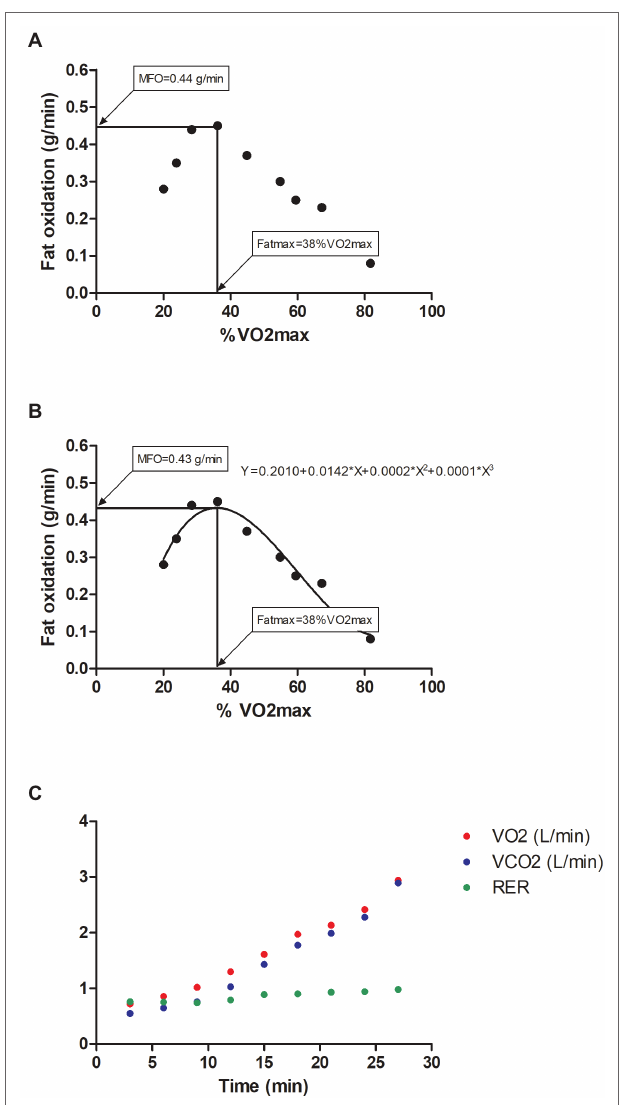
FIGURE 1 | Case study example of a single participant. (A) It shows maximal fat oxidation during exercise (MFO) and the intensity that elicit MFO (Fatmax) using the measured-values data analysis approach (i.e., the highest fat oxidation rate recorded across the graded exercise protocol). (B) It shows MFO and Fatmax building a 3rd polynomial curve with intersection at (0,0) from a graphical depiction of fat oxidation data as a function of exercise intensity expressed as percentage of the maximal oxygen uptake. (C) It shows the single participant response to VO2/VCO2 exchange and respiratory exchange ratio during the graded exercise